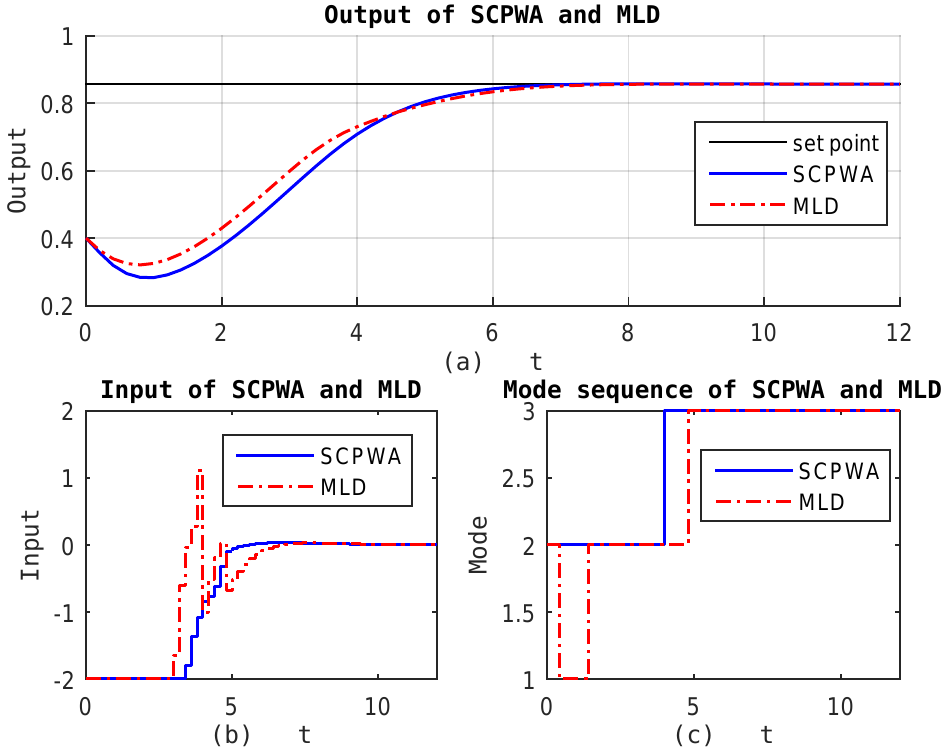
Figure 7. Output, input, and mode trajectories of MLD and SCPWA–MPC, where SCPWA has a fixed mode switching sequence and overlapping operating subspaces.